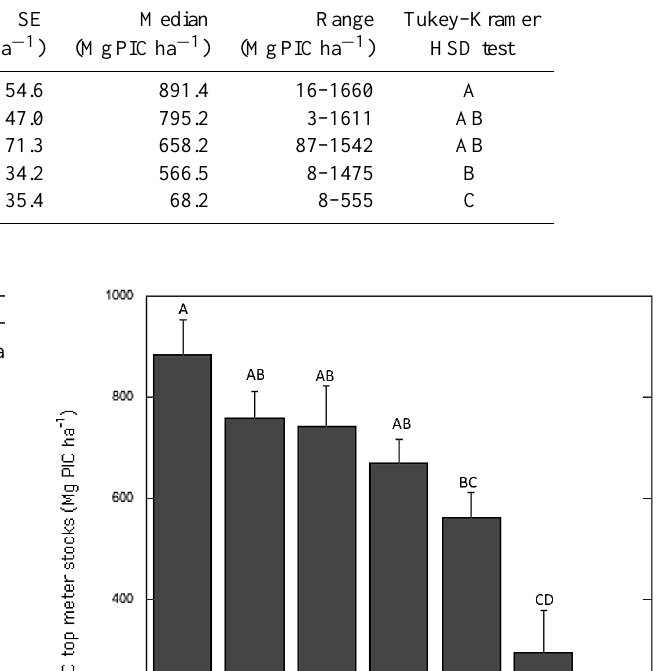
Table 1. Number of observations, mean ± standard error, median and range of values for the PIC stocks in each biogeographic region (Tropical Western Atlantic, Indo-Pacific, Mediterranean, Southern Australia and Northern Atlantic). The results of the comparison among different regions (Tukey–Kramer HSD (honest significant difference) test) are shown in the last column where different letters represent a significant difference ( p < 0.05).